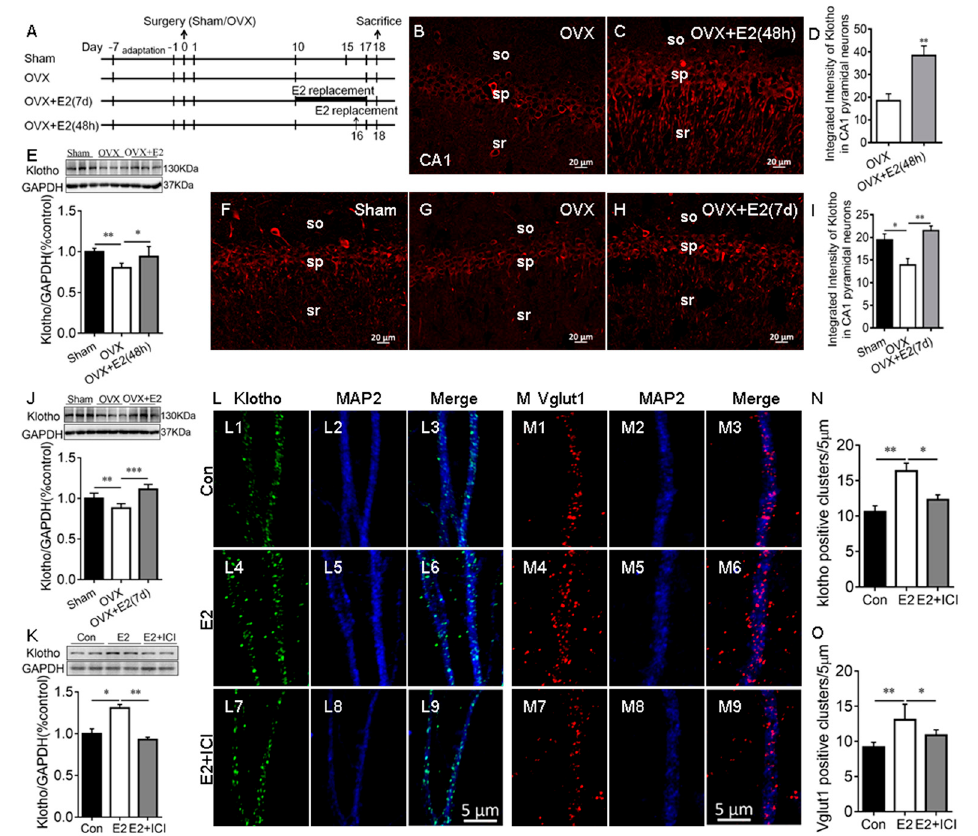
Figure 1. E2 increased Klotho expression in the hippocampus of ovariectomized (OVX) rats and cultured hippocampal neurons. Experimental design ( A ). Representative images of KL immunostaining (red) in the hippocampal CA1 area of sham, OVX, and E2-treated OVX (OVX + E2) rats (48 h after vehicle or E2 injection ( B , C ); daily vehicle or E2 injection for 7 days ( F – H )). Quantification of fluorescence intensity of KL staining in the hippocampal CA1 area (48 h ( D ); 7 d ( I )). Western blot showing the relative KL protein levels in the hippocampus of sham, OVX, and OVX + E2 rats (48 h ( E ); 7 d ( J ); n = 6). The cultures were treated with the vehicle (Con), 10 nM E2, and E2 + 1 µ M ICI (ICI182,780, estrogen receptor inhibitor) at Div13 for 48 h. Western blot result of hippocampal lysate prepared from primary hippocampal culture ( K ). Immunostaining of cultured hippocampal neurons with antibodies specific to KL and MAP2 in Con, E2, and E2 + ICI neurons ( L ). KL staining (green, L1, L4, L7), MAP2 staining (blue, L2, L5, L8), and merge of KL and MAP2 (L3, L6, L9). Quantification of KL-positive clusters in cultured hippocampal neurons ( N ). Immunostaining of cultured hippocampal neurons with antibodies specific to Vglut1 and MAP2 in Con, E2, and E2 + ICI neurons ( M ). Vglut1 staining (red, M1, M4, M7), MAP2 staining (blue, M2, M5, M8), and merge of Vglut1 and MAP2 (M3, M6, M9). The number of Vglut1-positive clusters in cultured hippocampal neurons ( O ). SO, stratum oriens of CA1 area; SP, stratum pyramidale of CA1 area; SR, stratum radiatum of CA1 area; Con, control. Data are shown as the mean ± SEM. D with the t -test, and others with one-way ANOVA followed by Tukey’s test. * p < 0.05, ** p < 0.01, *** p < 0.001.